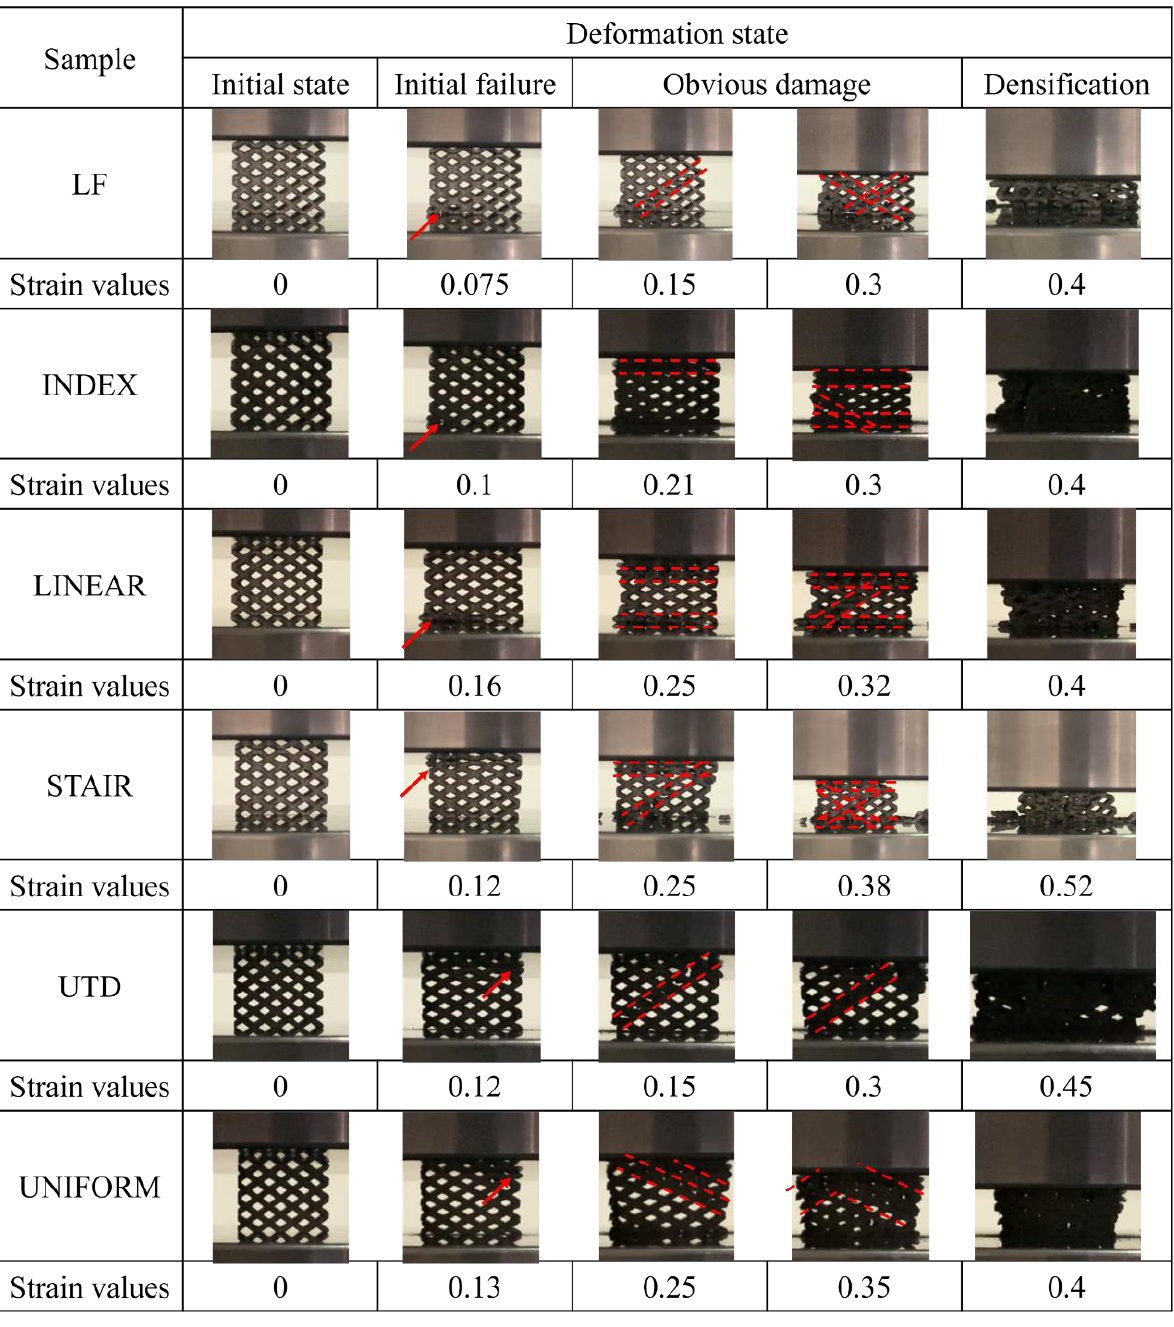
Figure 7. Deformation behavior of different lattice structures (The arrow indicates the location where the lattice structure first broke, and the dotted line indicates the diagonal shear break or crush of the lattice